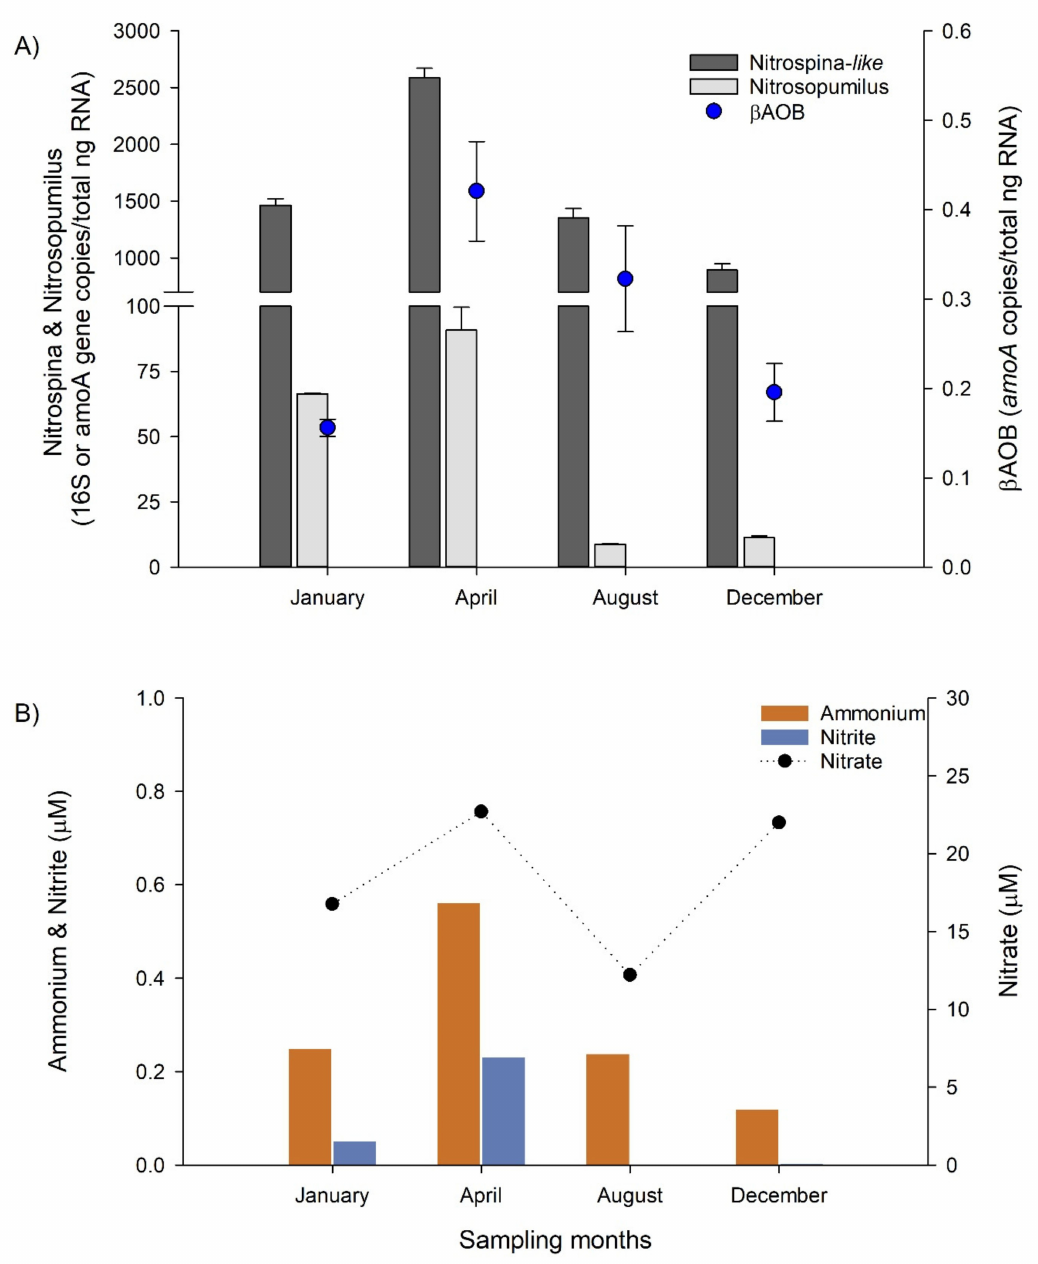
Figure 8. ( A ) Quantification of key nitrifying microbial functional groups in the bottom water, including ammonia oxidizing archaea (Nitrosupumilus-like), ammonia oxidizing bacteria ( β AOB) and nitrite oxidizing bacteria (Nitrospina-like). ( B ) Nutrients associated with nitrification process from bottom